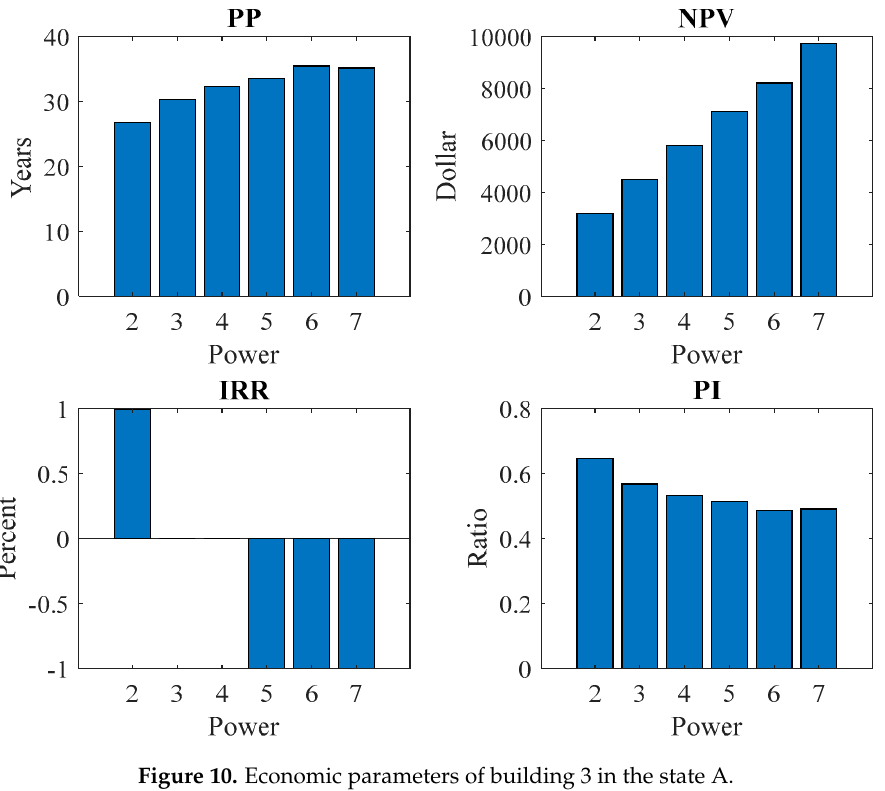
Figure 9 Economic parameters of building 2 in the state A.